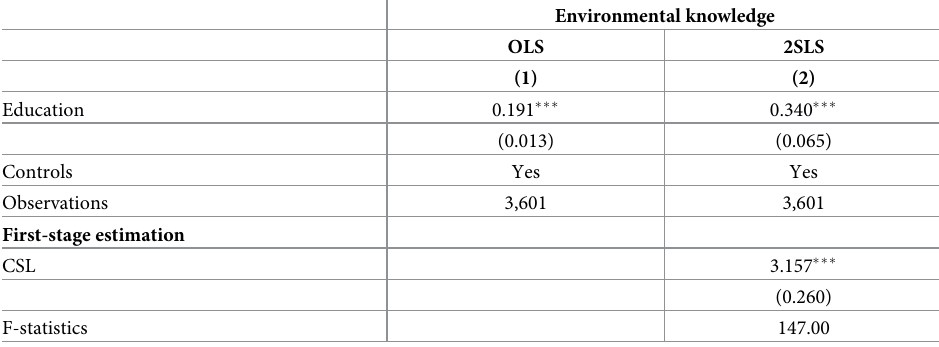
Table 8. The effects of education on environmental